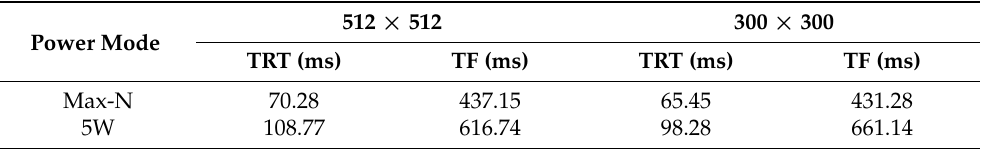
Table 6. Inference time measured on the NVIDIA Jetson Nano device for every combination of image size, power mode and optimization